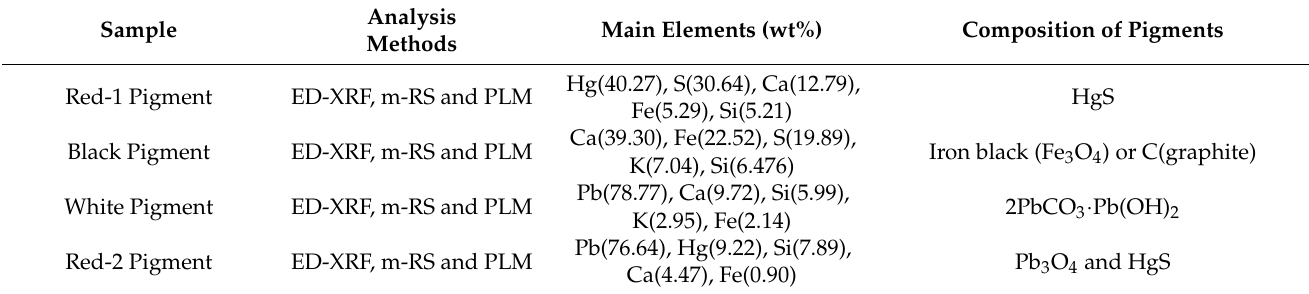
Table 3. Information on sample and elemental composition of the